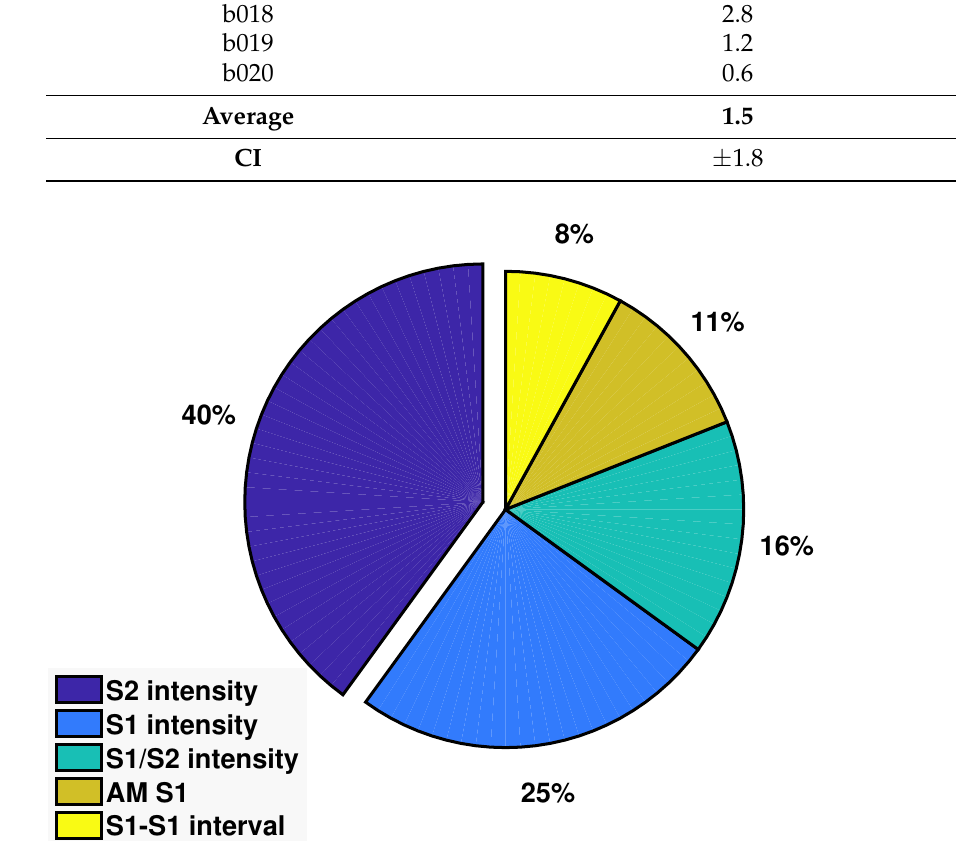
Figure 9. Distribution of respiratory windows based on method